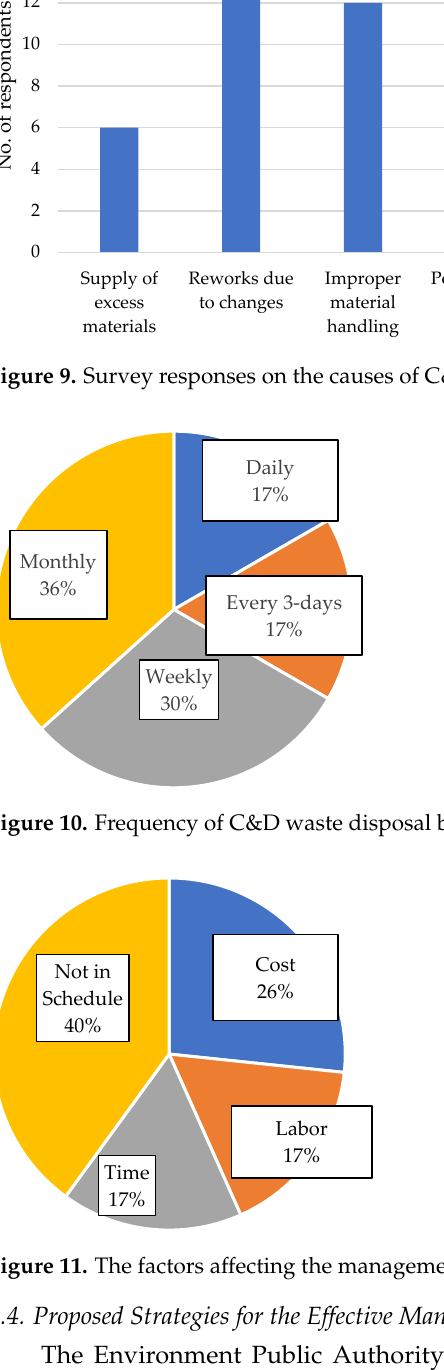
Figure 11. The factors affecting the management of C&D waste.